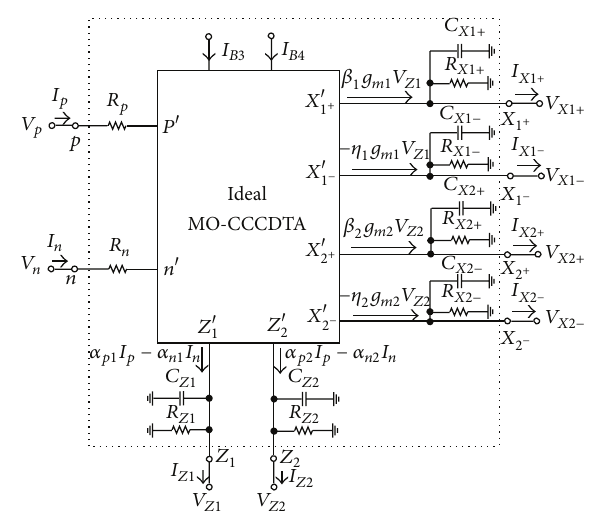
Figure 3: Nonideal equivalent circuit model of the